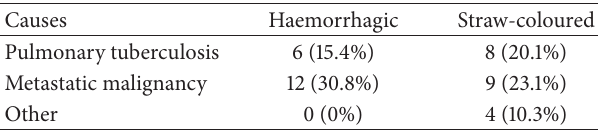
Table 2: The 39 patients with haemorrhagic or straw-coloured pleural